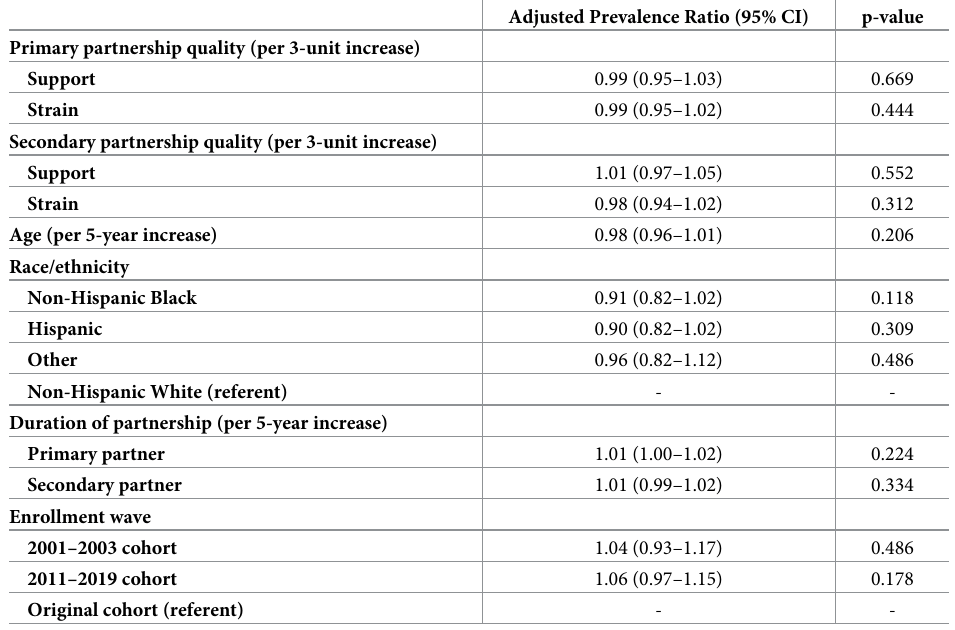
Table 6. Adjusted association of partnership and secondary partnership quality and viral load suppression among participants reporting both primary and secondary